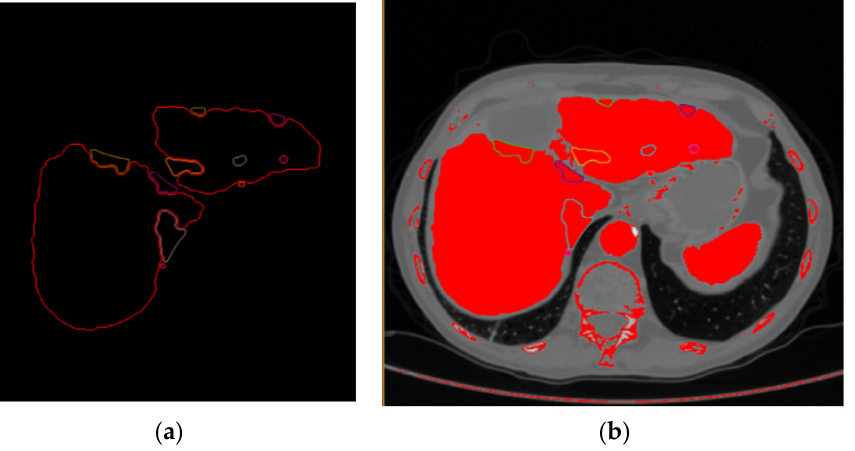
Figure 2. Liver segment extraction. Extraction of hepatic parenchyma ( a ) by fully automated or semi-automated methods by delineating liver boundaries from neighboring tissue ( b ). The procedure was applied in each one of the DICOM images of the artery CT scan phase.